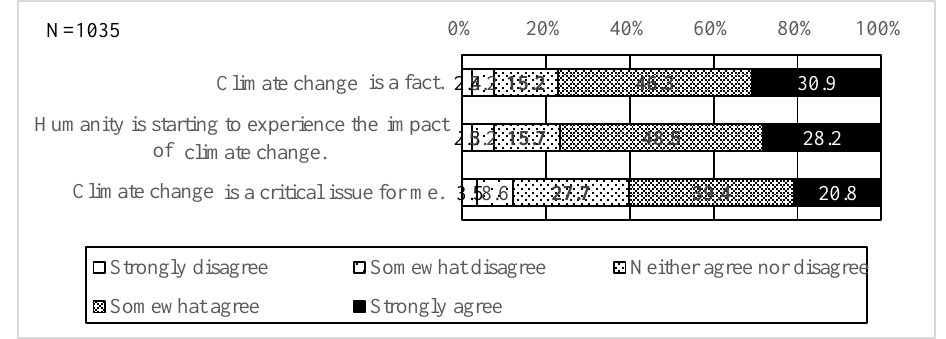
Figure 1. Perception of climate change risks